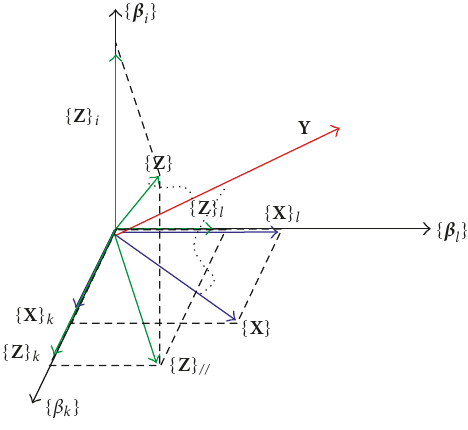
Figure 1: Projection of the signal and noise subspaces { X } (blue), and { Z } (green), respectively, onto a fixed orthogonal basis space. The space is assumed to be completely spanned by three orthogonal basis { β l } , { β k } , and { β i } for